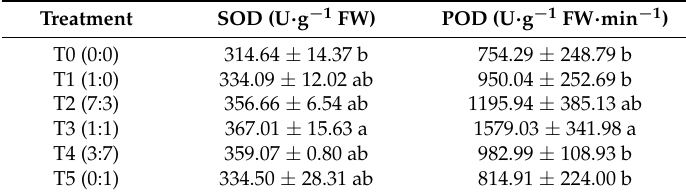
Table 4. Peroxidase (POD) and Superoxide Dismutase (SOD) activities in leaves of Camellia oleifera ‘Xianglin 27’ seedlings fertigated with six nutrient solutions varying in NO 3 − to NH 4+ ratios.